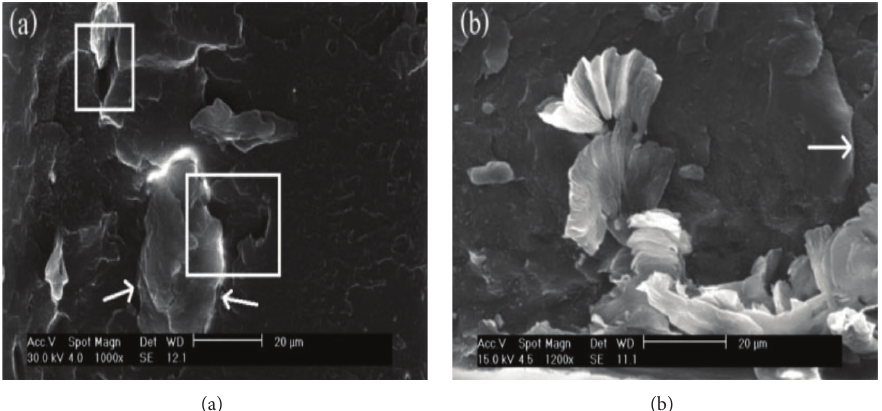
Figure 1: SEM micrographs of the fractured surface of composites films with varying MMT content: (a) 0 and (b) 6 wt% of MMT content